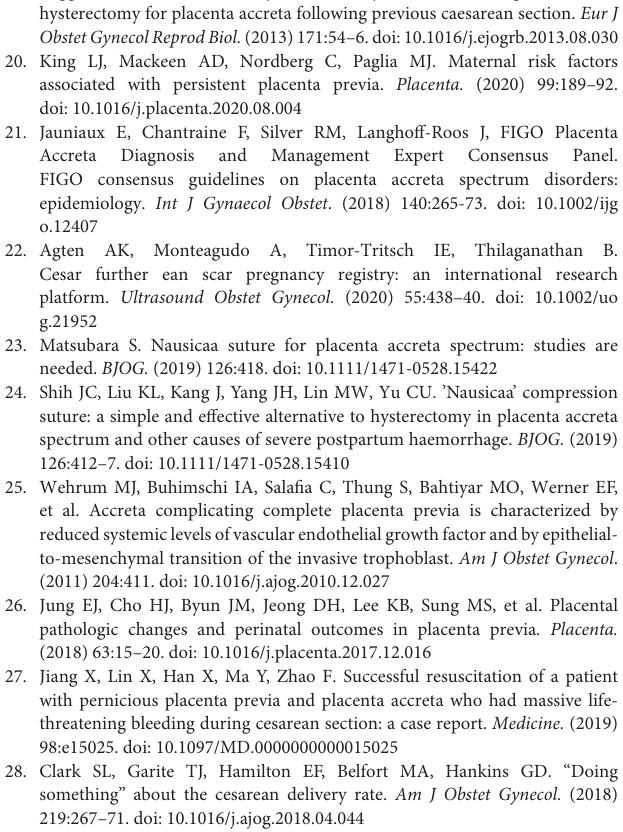
FIGO consensus guidelines on placenta accreta spectrum disorders: epidemiology. Int J Gynaecol Obstet . (2018) 140:265-73. doi: